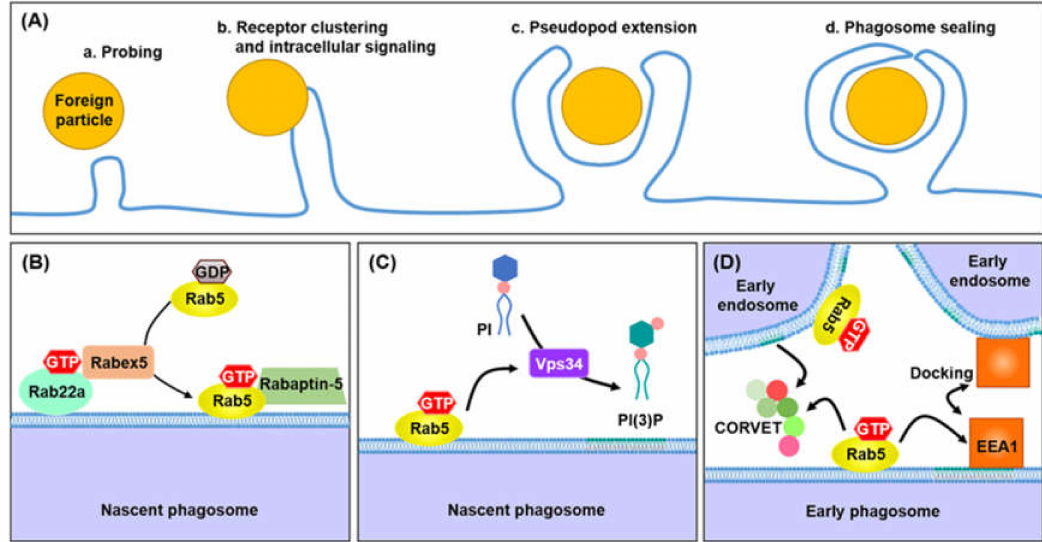
Figure 4. Maturation of the early phagosome. ( A ) (a) During the process of ‘probing’, the membrane expands via cytoskeletal rearrangement to recognize foreign particles using phagocytic receptors. (b) The interaction between phagocytic receptors and ligands derived from foreign particles induces receptor clusters and activates intracellular signaling pathways responsible for the formation of phagocytic cups. (c) The expansion of pseudopods is induced by the continuous assembly of actin filaments, which leads to the elongation of membranes. (d) Finally, the pseudopod surrounds the target particles and seals the distal tip of the phagocytic cup. ( B ) Following the internalization of foreign particles, the nascent phagosome begins to acquire the proteins needed for its maturation into the early phagosome. GTP-bound Rab22a recruits Rab5 GEF Rabex-5 into the phagosomal membrane. Rabex-5 converts GDP-bound Rab5 to GTP-bound Rab5, an activated form of Rab5. GTP-bound Rab5 induces the recruitment of Rabaptin-5 to further promote the activation of Rab5. ( C ) PI3K Vps34 accumulates in phagosomal membranes via Rabaptin-5, and generates phosphatidylinositol 3-phosphate (PI(3)P) from phosphatidylinositol (PI). ( D ) PI(3)P and GTP-bound Rab5 promote the recruitment of EEA1, which enhances the interaction between early endosomes and early phagosomes, by docking at the membrane of early endosomes. GTP-bound Rab5 also recruits the CORVET complex, to strengthen the fusion of early